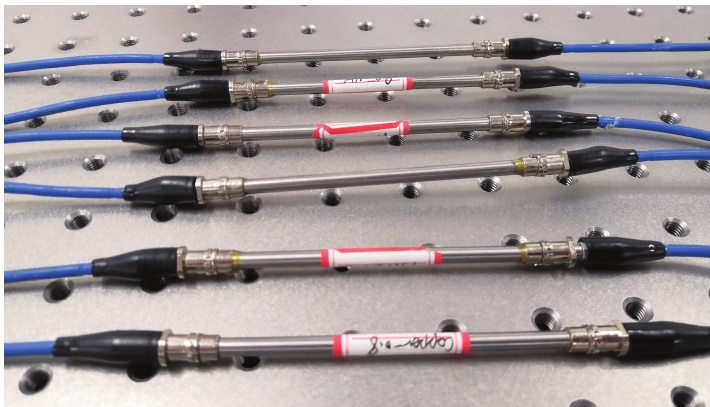
Figure 3. Double-thimble-type FBG temperature sensors developed in the